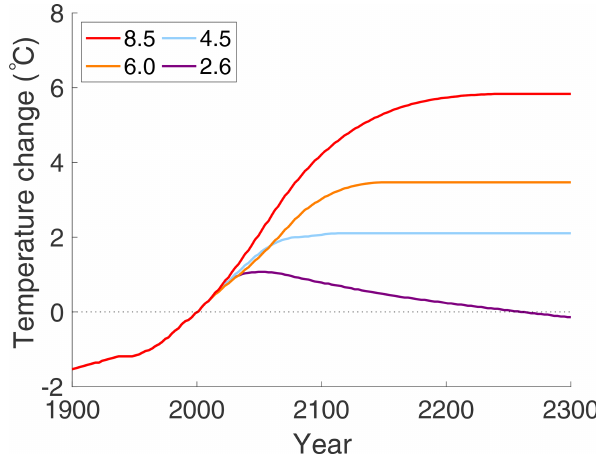
Figure 12. Change in globally averaged surface temperature, rela- tive to year 2000 global average temperature of 17.59 ◦ C, calculated to the year 2300 for the EBM on each of the four RCPs.